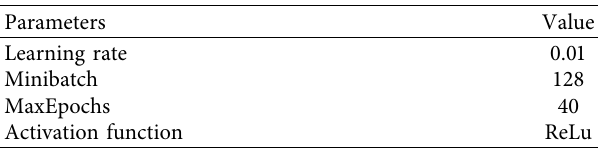
Figure 9: Original scanning real part imaging of titanium plate defects. Table 3: Parameters of the CNN. Table 4: Classification accuracy using original